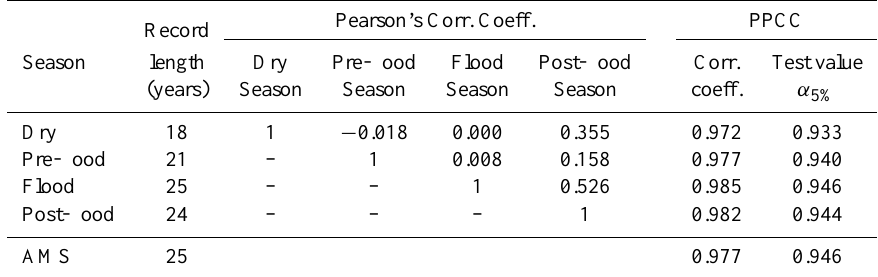
Table 1. Pearson’s seasonal correlation coefficients for the Blue Nile River at Sudan Border. The second to last column reports the linear correlation coefficient between seasonal flood flows and the associated Gumbel reduced variate; the last column shows the PPCC test value for assessing the goodness of the fit of the Gumbel (i.e. EV1) distribution for a significance level of 5%.